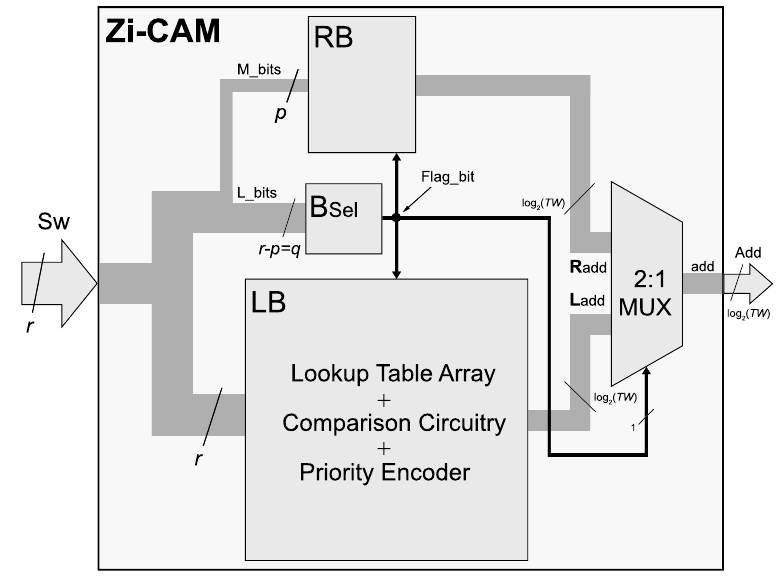
Figure 3. Zi-CAM Architecture. (LB: lookup tables block, RB: RAM block, BSel: Block Selector, Sw: